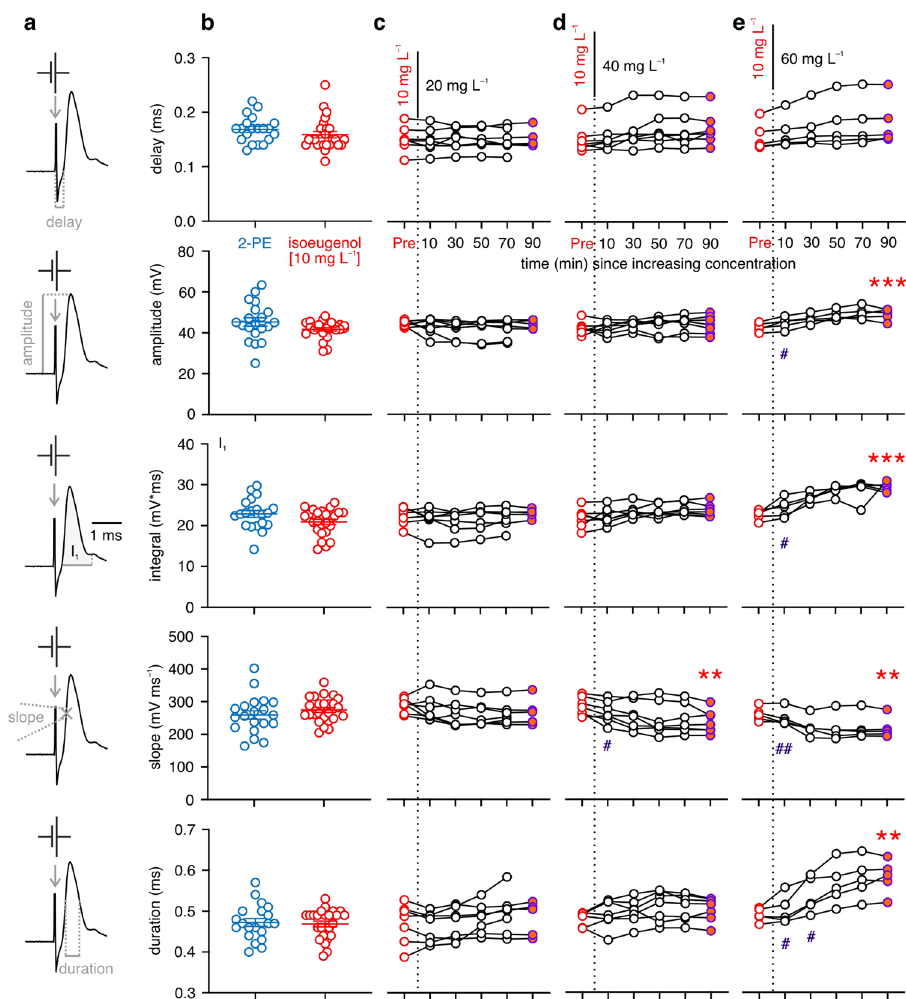
Fig. 2 Isoeugenol affects the action potential of a central neuron only at high concentration. a Example of an action potential (AP) recorded in the Mauthner neuron (MN) to illustrate the measurements taken. b In fi sh anesthetized with isoeugenol at the concentration of 10 mg L − 1 ( n = 25; red circles indicate individual fi sh) no effect was seen on the AP, i.e., all values were not signi fi cantly different from those determined in control fi sh anesthetized with 2-PE [400 mg L − 1 ] ( n = 20; blue circles). Means ± standard errors of mean are indicated. c – e Dotted vertical lines indicate moment of change to higher concentration at time = 0 min. Connected circles indicate mean values in individuals. c No signi fi cant changes after increase in isoeugenol concentration from 10 to 20 mg L − 1 ( n = 7 fi sh). d , e At 40 ( n = 7 fi sh) and 60 mg L − 1 ( n = 5 fi sh), the slope of the AP decreased slightly within 10 – 30 min after increasing dose. At 60 mg L − 1 , peak amplitude, I 1 and the duration of the AP were also affected. Effects also took more than 10 min to occur. Red asterisks highlight signi fi cant differences between values at baseline concentration (Pre; red circles) and values obtained 90 min after the increase in concentration (orange- fi lled circles). Violet hashtags indicate signi fi cant differences between values obtained 90 min after dose increase (orange- fi lled circles) and values determined also after dose increase but earlier (black-outlined circles). One, two, three symbols indicate P ≤ 0.05, P ≤ 0.01, or P ≤ 0.001, PSPs. Figure 3 reports fi rst the effects on the acoustic PSPs.